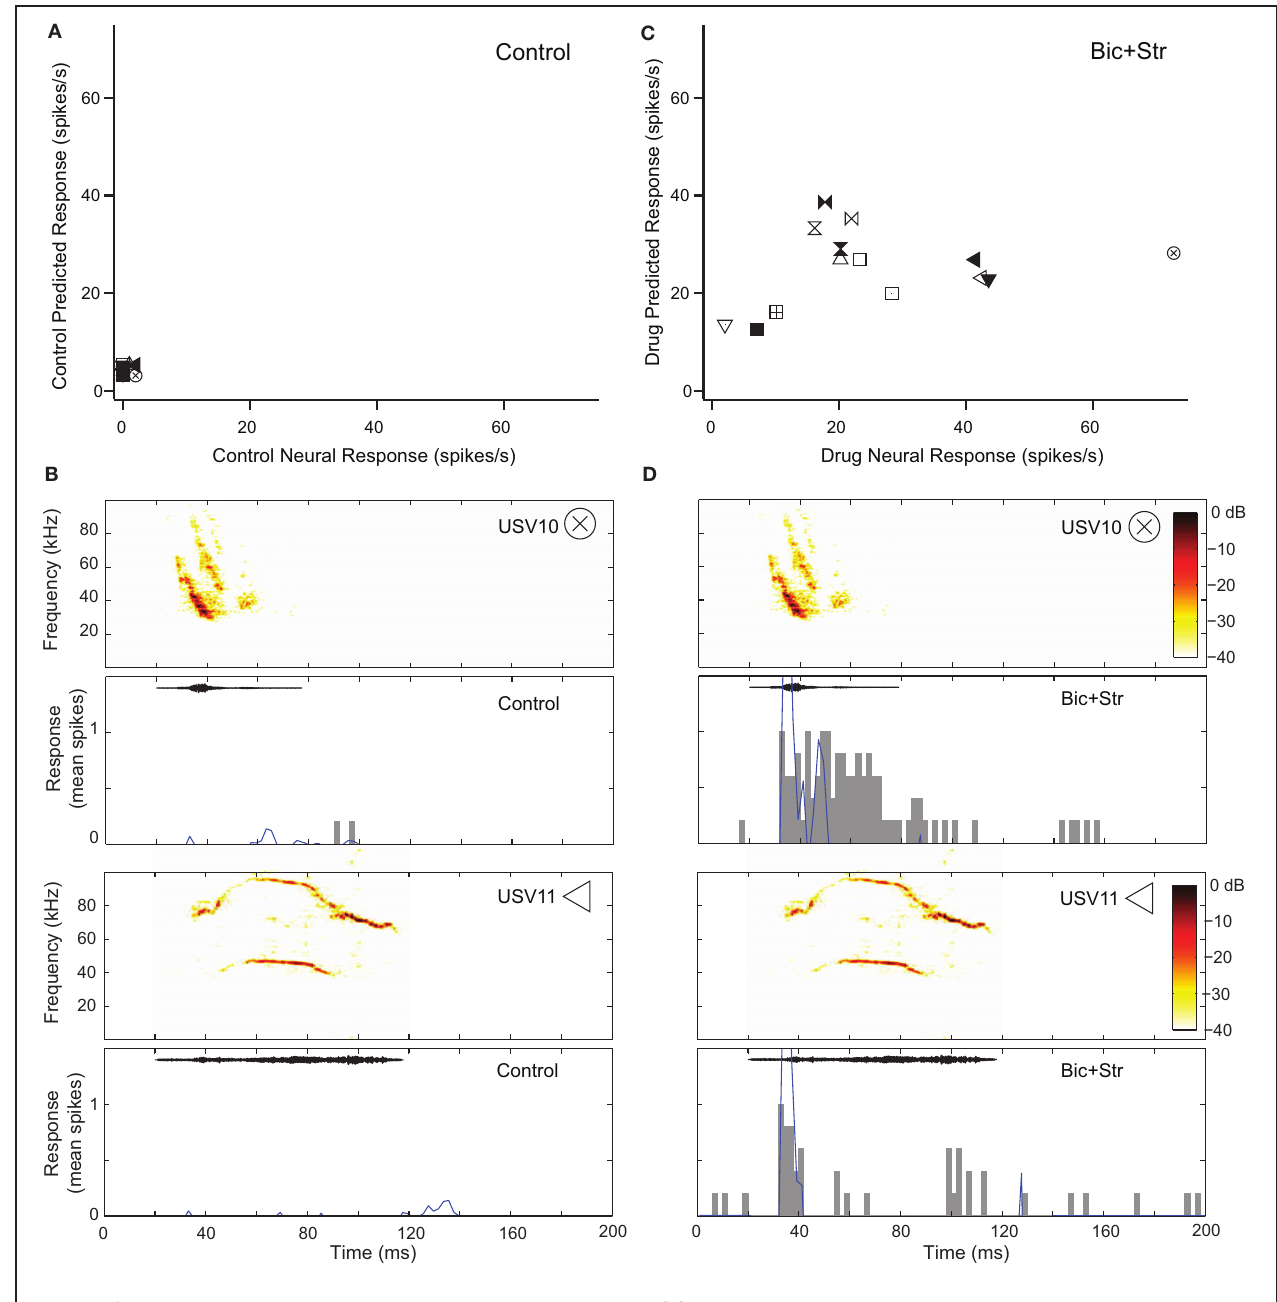
FIGURE 6 | Decreased selectivity to vocalizations can occur with a change in the shape of the excitatory frequency tuning curve. (A) Predicted and actual response rates of one neuron (same as in Figure 2B ) to all the vocalizations in the control condition. (B) Predicted (blue lines) and actual responses (gray bars) to two vocalizations in the control condition.